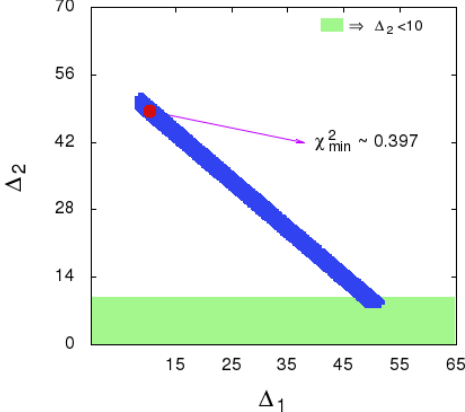
Figure 6 . Washout parameters for N 2